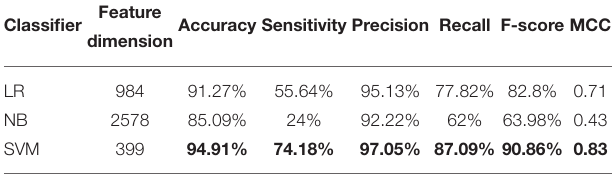
TABLE 3 | Cross-validation performances of optimized TPC using different classifiers on PM275.